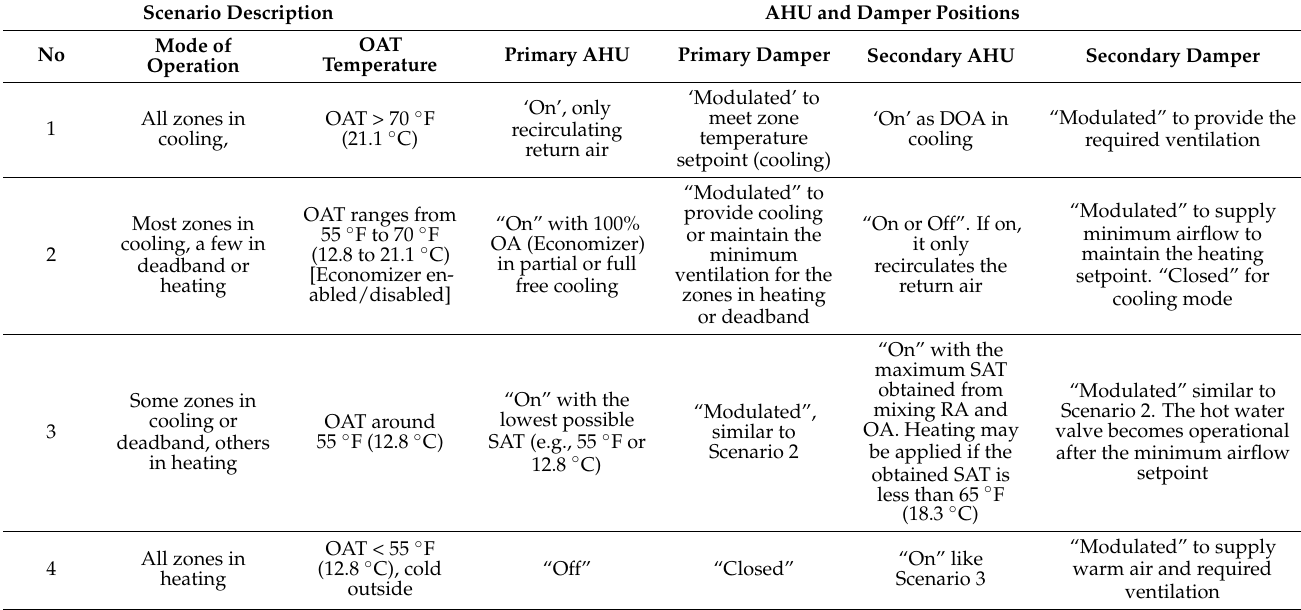
Table 1. The sequence of operation for dual VAV system and